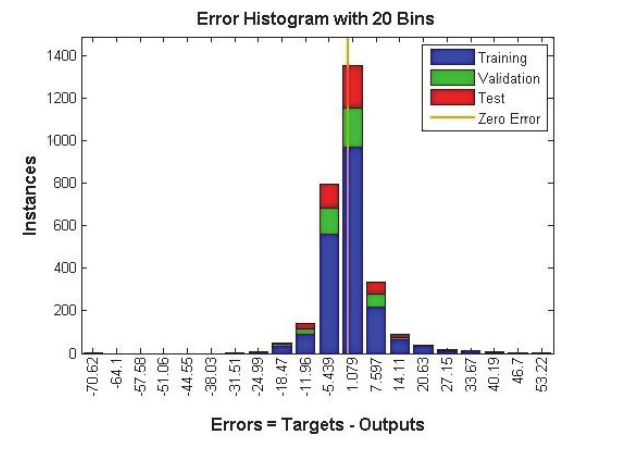
Fig. 8. Error histogram of MCS